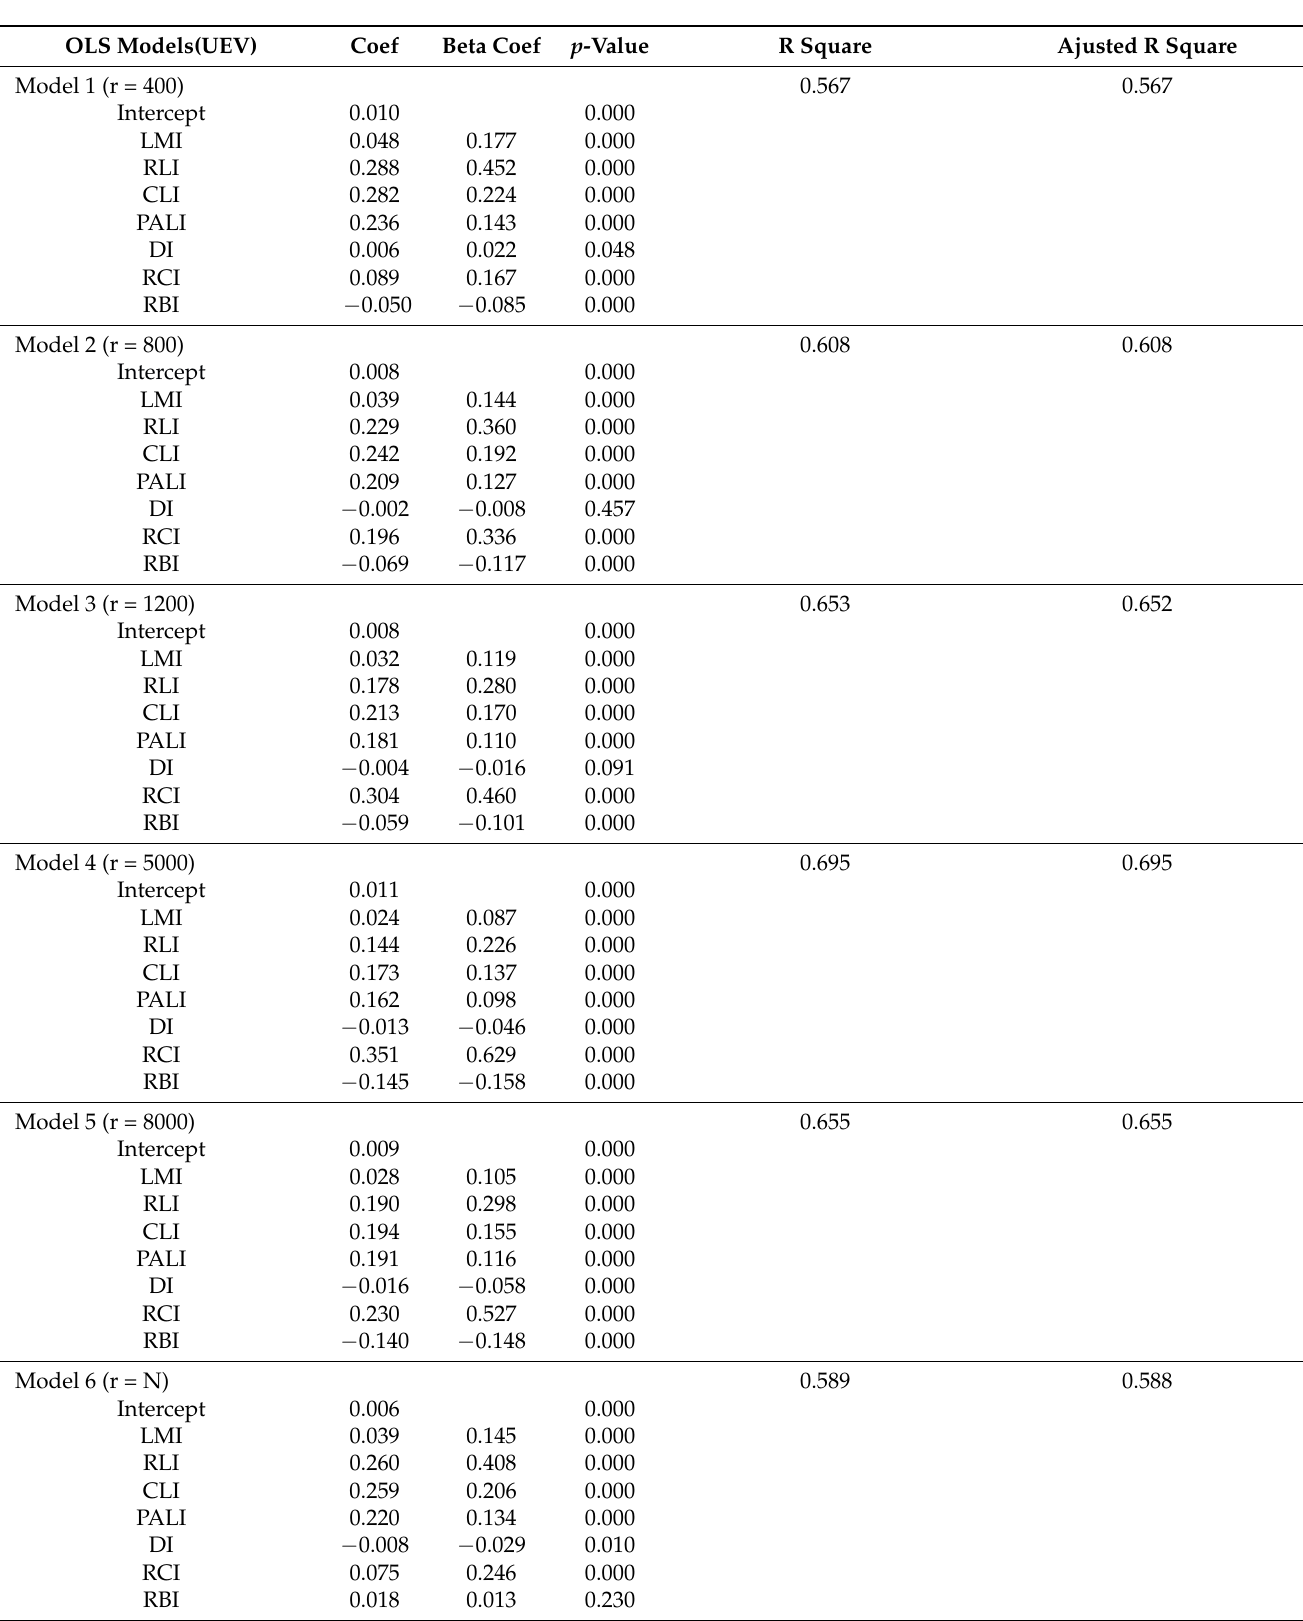
Table A5. The resulting for ols model between UEV and built environment variables under different search